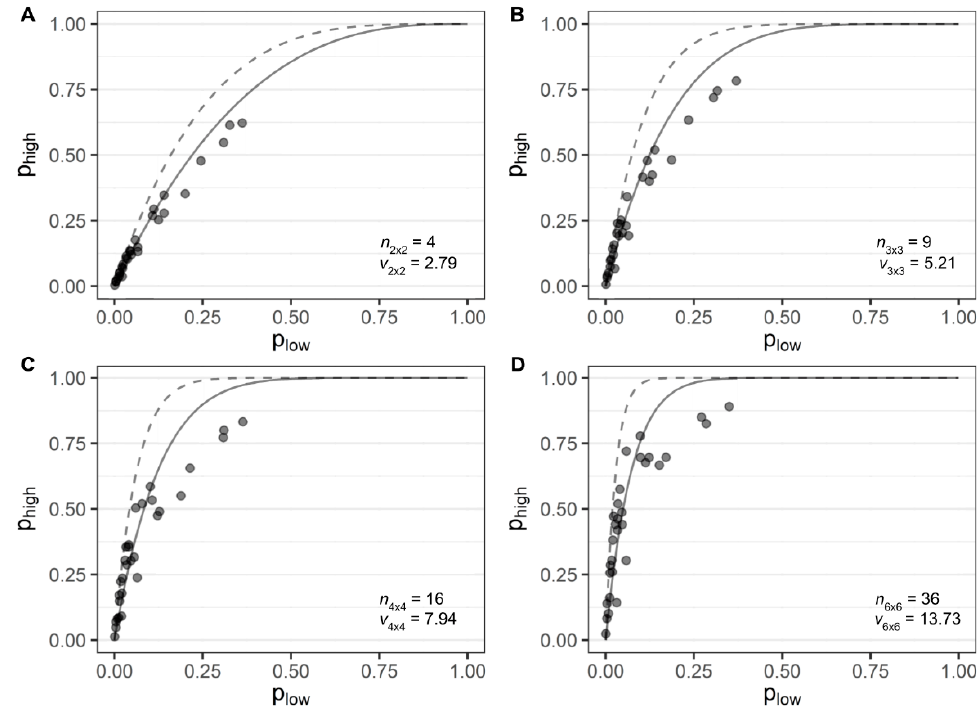
Figure 3. Relationships between the incidence of Fusarium wilt of banana at ( A ) 2 × 2; ( B ) 3 × 3; ( C ) 4 × 4; and ( D ) 6 × 6 quadrat dimensions in 30 banana fields. The sampling unit (quadrat) was the highest ( p high ) hierarchical level and the individual (plants) was the lowest ( p low ). Binomial (dashed-lines) and β -binomial (solid-lines) distributions were fitted to the data. The number of individuals ( n ) and the effective sample size ( v ) estimated at each level are presented in the graphs.